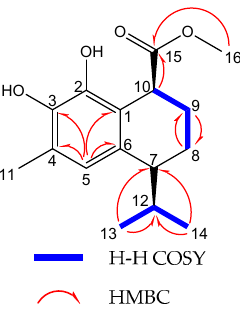
Figure 3. 1 H- 1 H correlated spectroscopy (COSY) and detected heteronuclear multiple bond correlation HMBC of 1 .